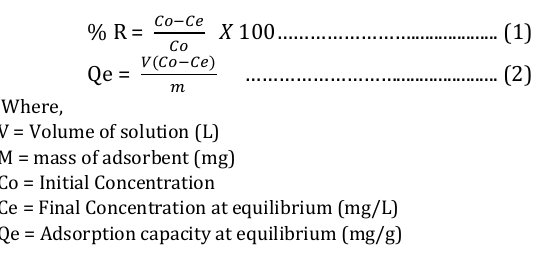
Figure 1: Banana ( musa sapientum ) peel biomass